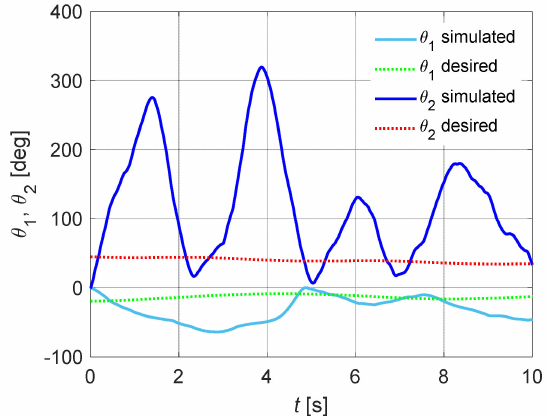
Figure 11. Angular displacements simulated and desired in azimuth and elevation with random interference—PID control.